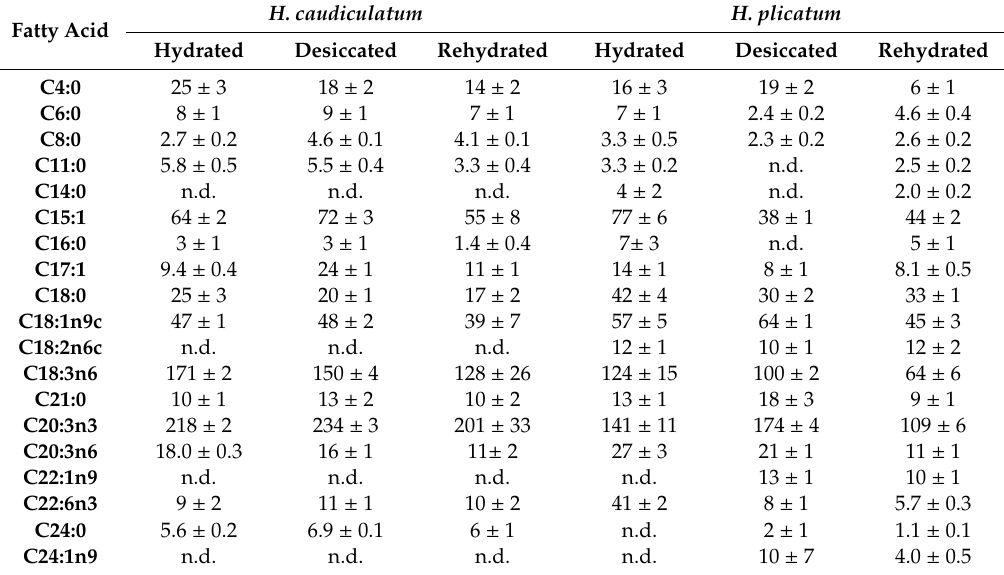
Table 2. Mean mass fraction ( µ g g − 1 Dry Weight) of individual fatty acid changes in the hydrated, desiccated and rehydrated fronds of two contrasting desiccation-tolerant filmy ferns subjected to a desiccation–rehydration cycle. Hymenophyllum caudiculatum , less desiccation tolerant, and Hymenophyllum plicatum , more desiccation